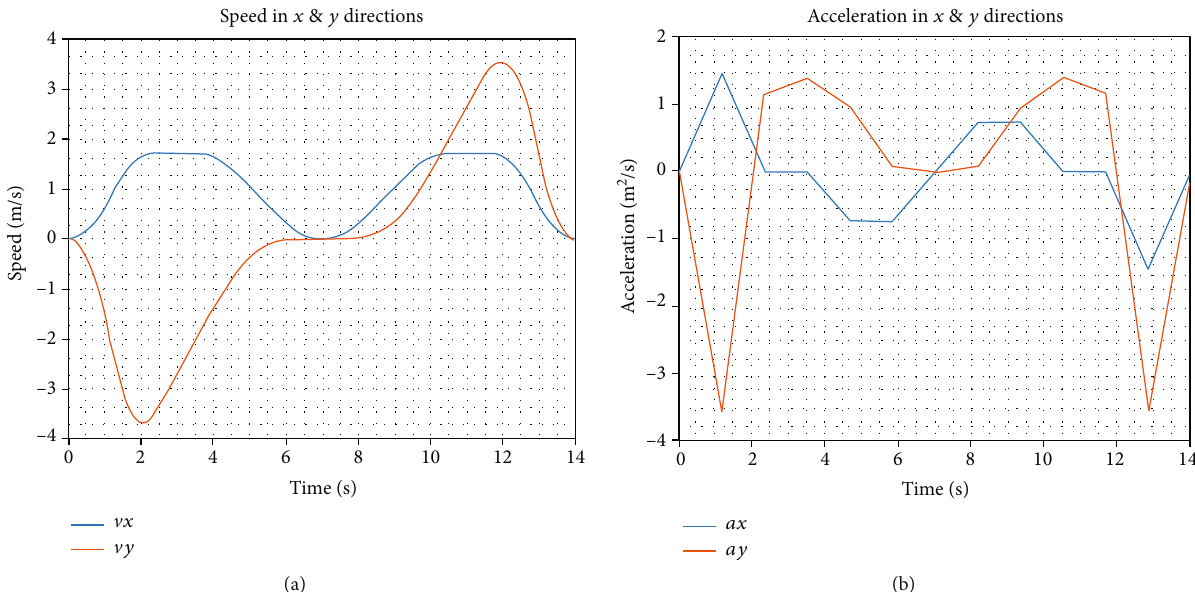
Figure 7: B-spline generated basis function path and speed curve. (a) Speed. (b) Acceleration.